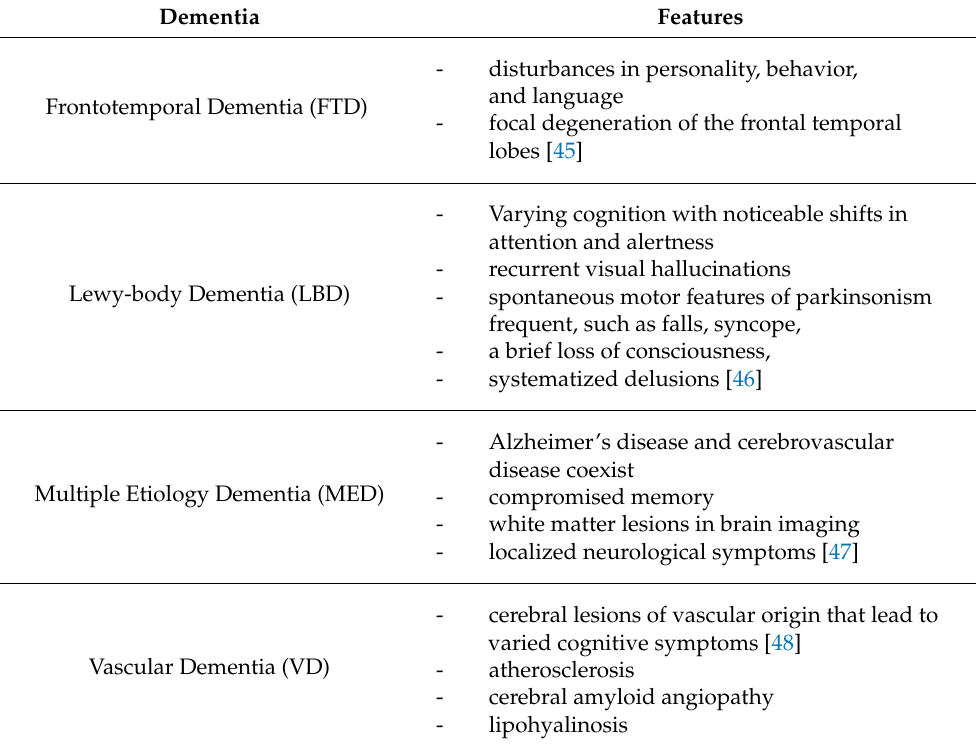
Table 1. Classification of dementias based on neuropathological